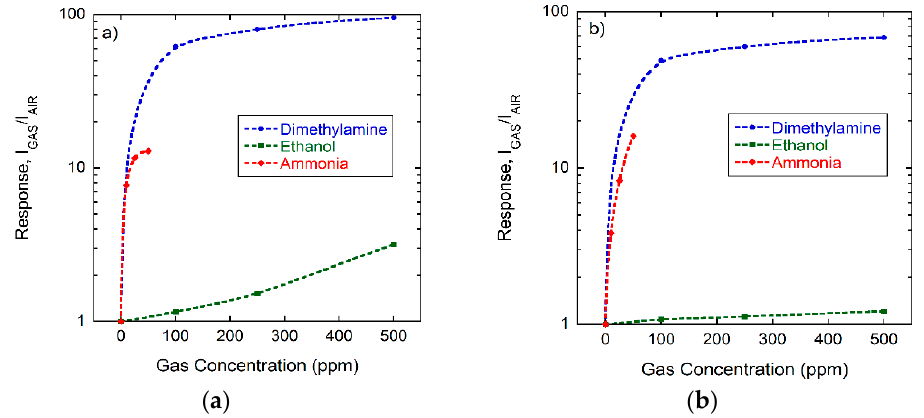
Figure 8. Response of CuO emitters to different concentrations of dimethylamine, ammonia, and ethanol applied in ( a ) dry and ( b ) humidified synthetic air (RH = 50% @ 20 °C). All measurements have been acquired with bias voltages of +200 V applied to the CuO electrode and with the sensor substrate heated to 400 °C.